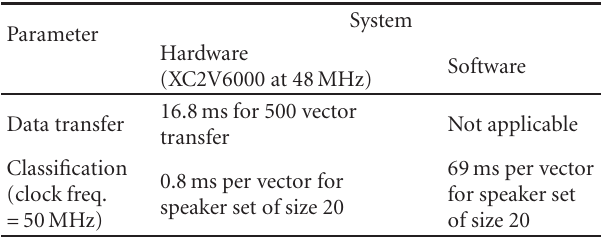
Table 2: Hardware and software results for testing with 5s of test